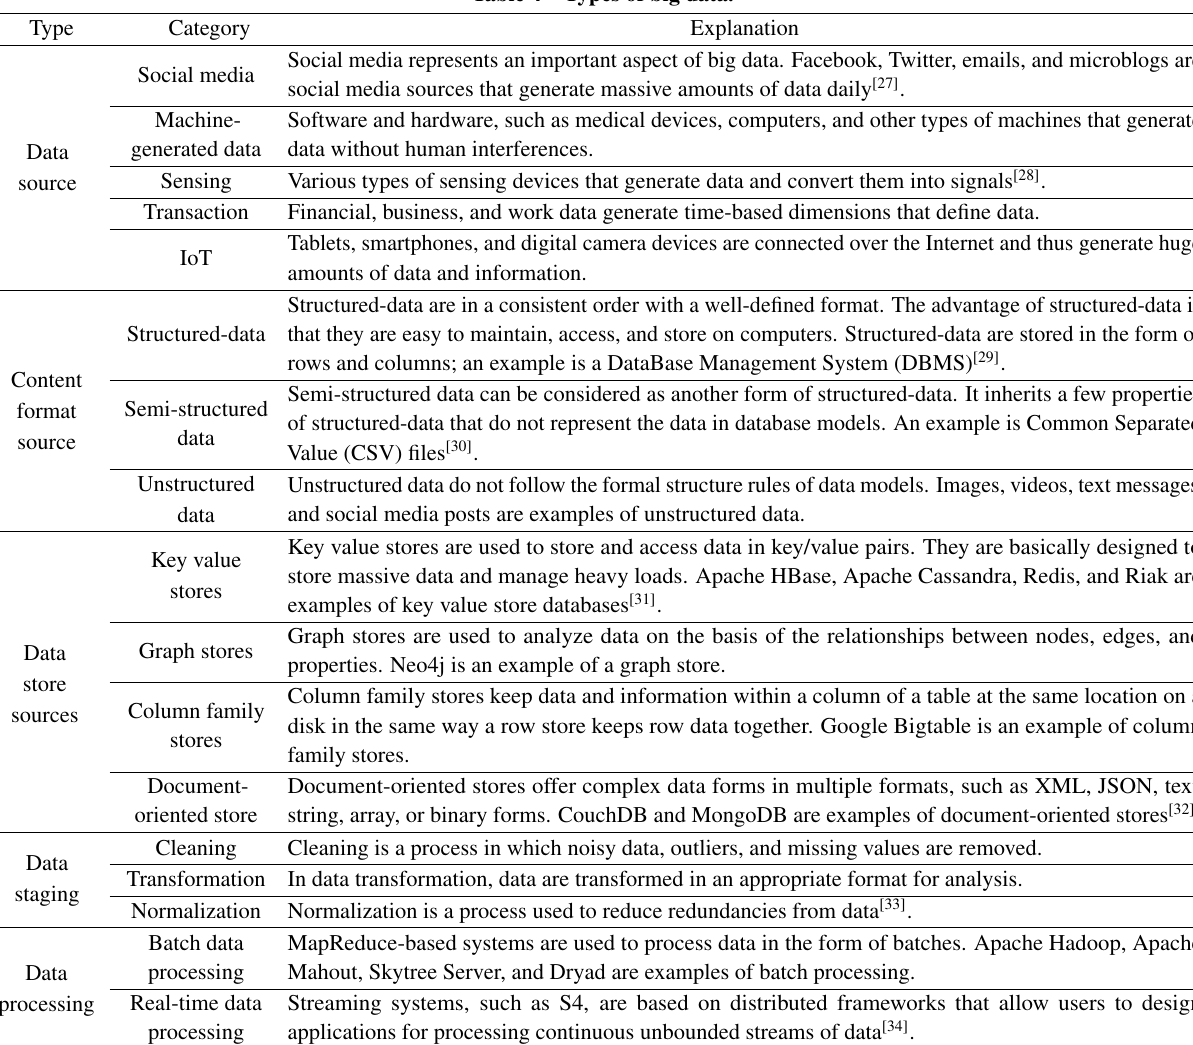
Table 4 Types of big